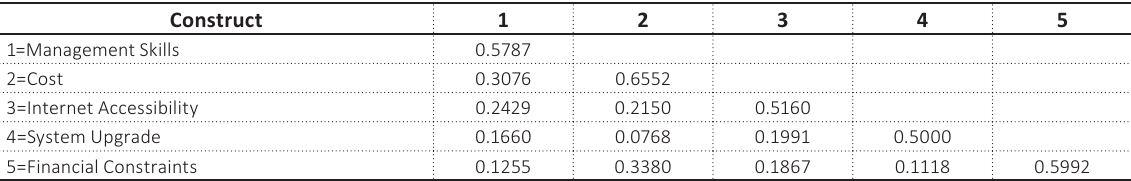
Table 5. Test of discriminant validity – Fornell-Larcker